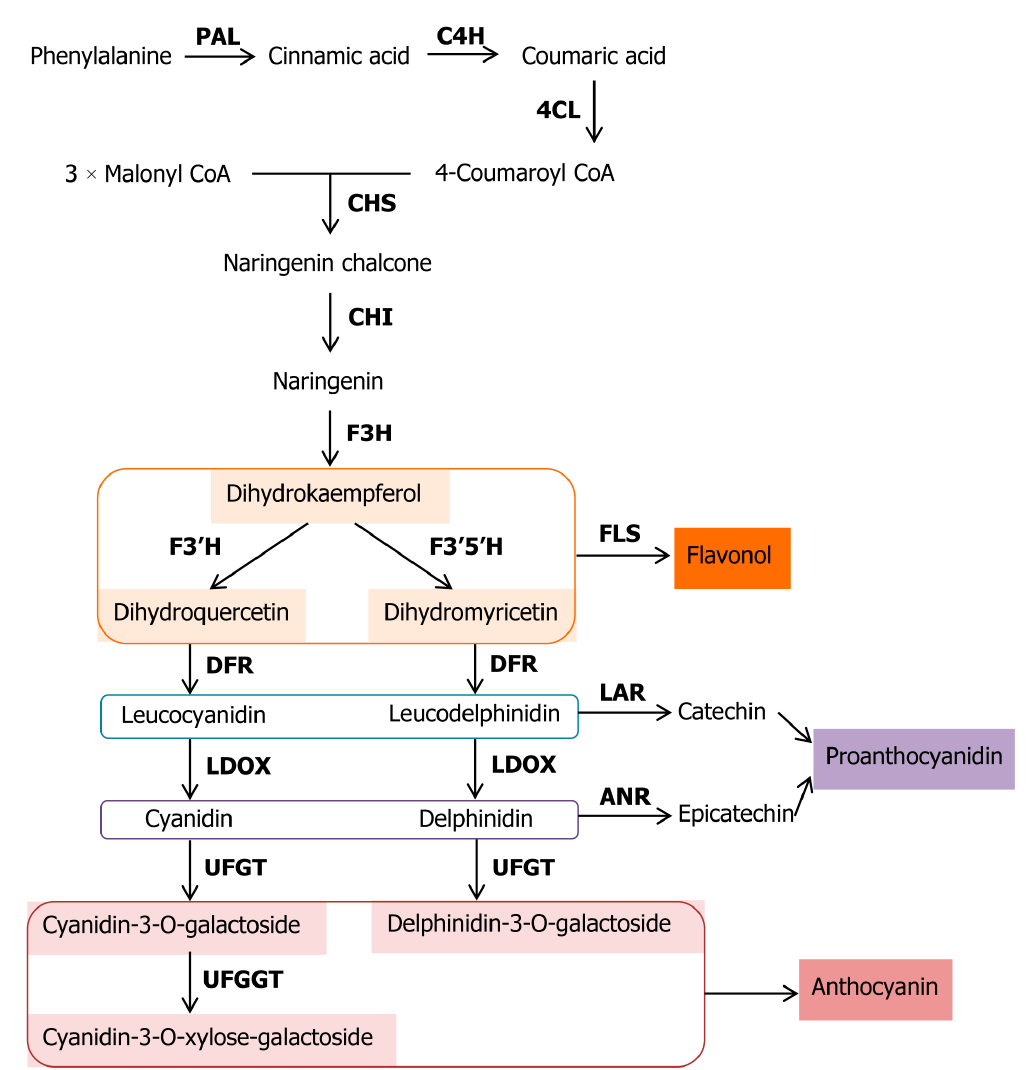
Figure 1. Anthocyanin biosynthetic pathway in kiwifruit. PAL, phenylalanine ammonia-lyase;